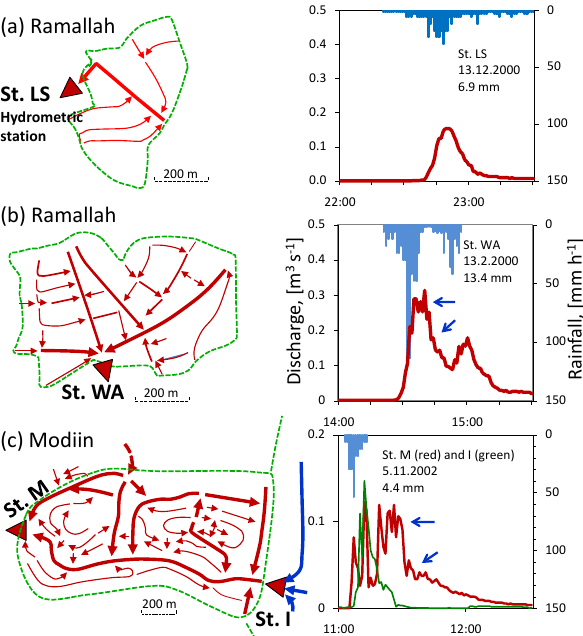
Fig. 9. Urban road network design and the hydrological response following small rainstorms. Note blue arrows indicate multi-peaks at the peak discharge and also at the